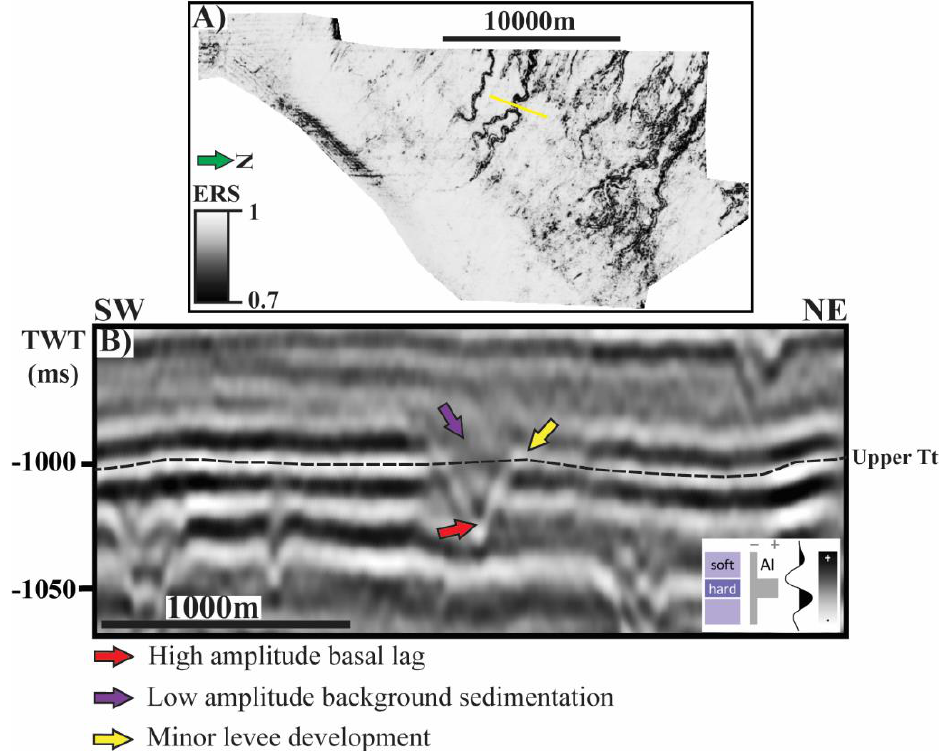
Figure 8. ( A ): ERS attribute extracted along Upper Tt in the Pipeline-3D survey. ( B ): Seismic ampli- tude section at the location noted by the yellow line in ( A ). Note the shallow incision depth, V- shaped channel complex, and minimal levee formation.